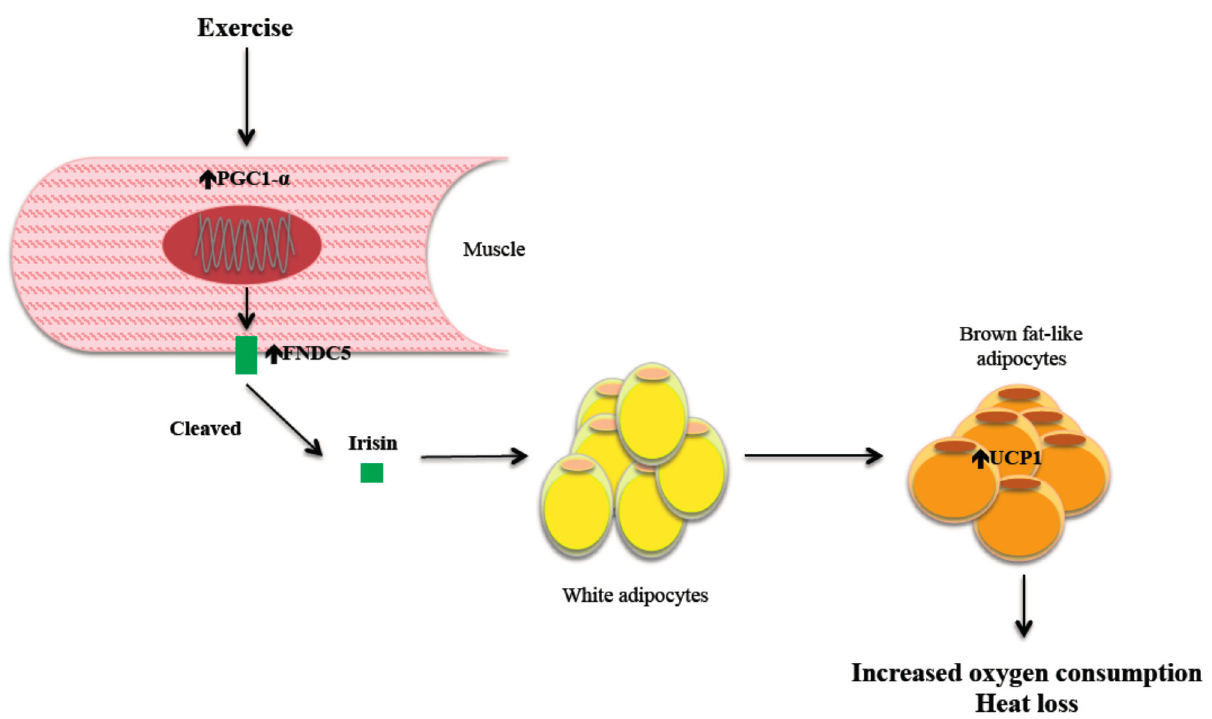
Figure 1. Irisin mechanism of